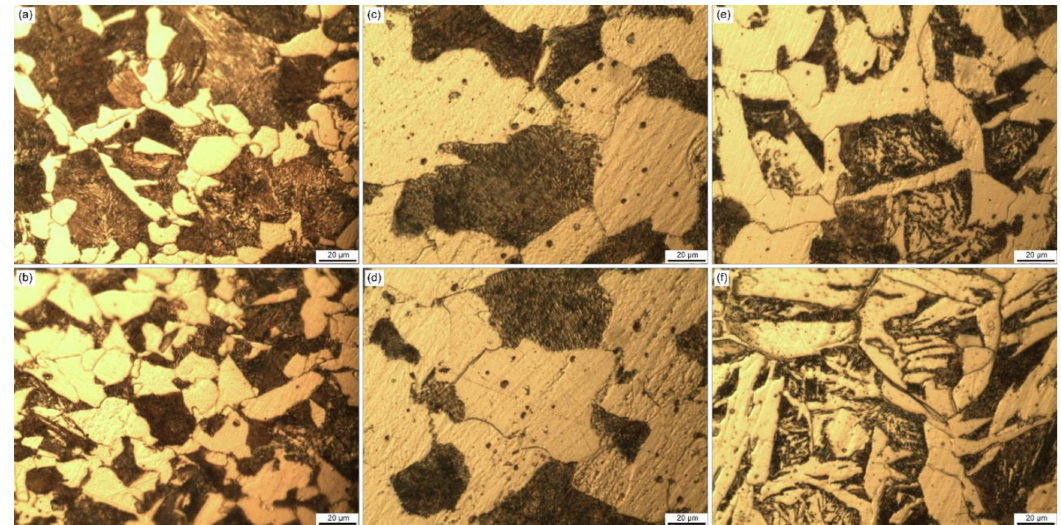
Figure 2. Micrography of rebars after thermomechanical treatments ( × 100): As received (( a ) center, ( b ) edge, Annealing (( c ) center, ( d ) edge), and Normalizing (( e ) center, ( f ) edge).